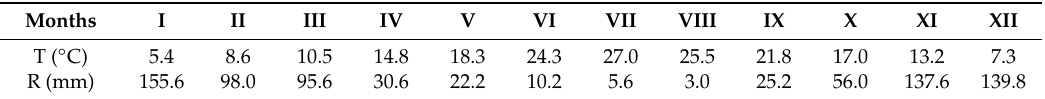
Table 1. Mean monthly values of air temperature (T) and rainfall (R) obtained during the study period, from January (I) to December